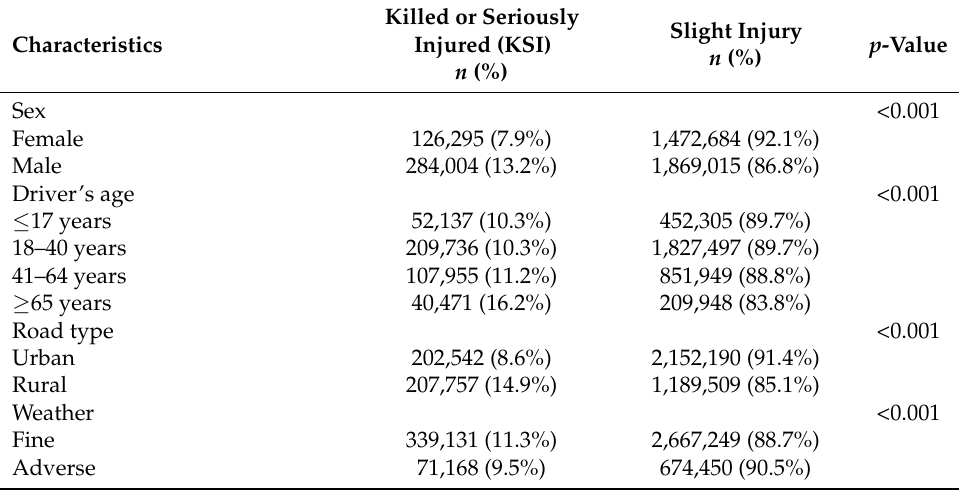
Table 2. Distribution of injury severity by risk factor during 1990–2017 (Data based on UK STATS19 1990–2017)